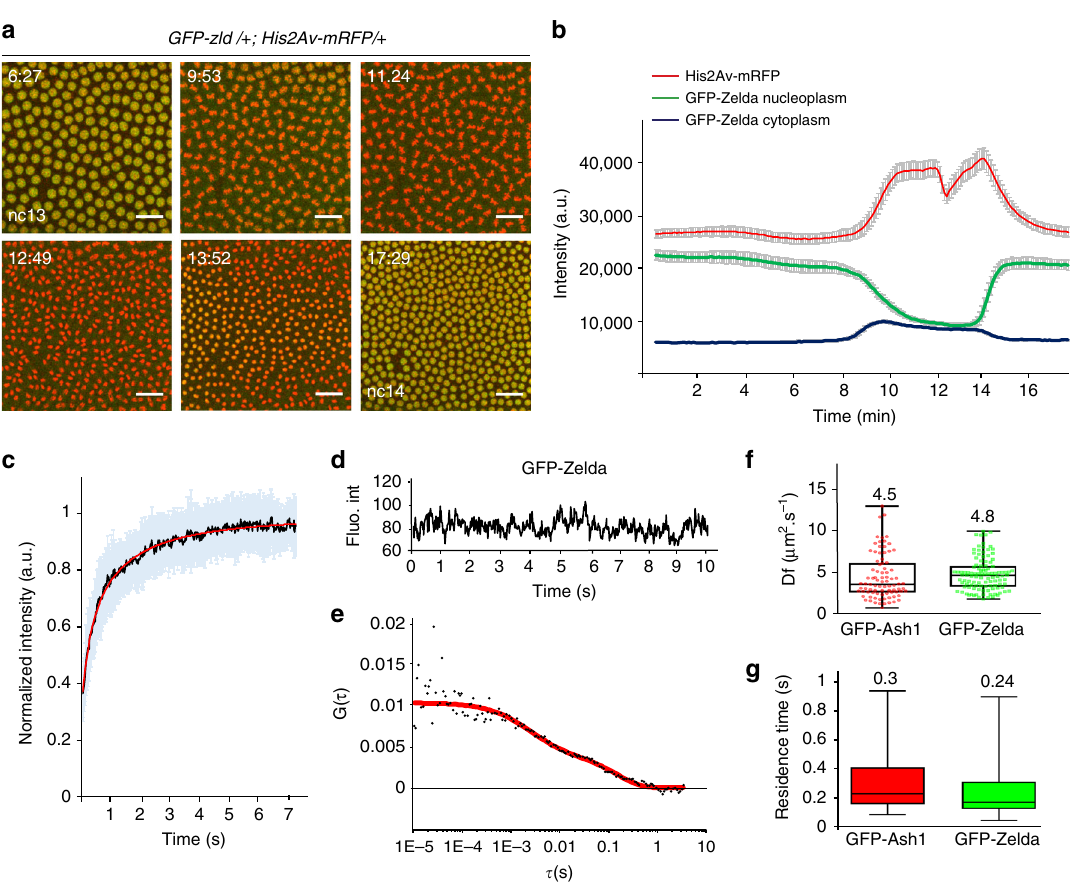
Fig. 5 Zelda global kinetic properties. a Living GFP-zld/ + ;His2Av-mRFP/ + embryo imaged by confocal microscopy from interphase of nc13 to early